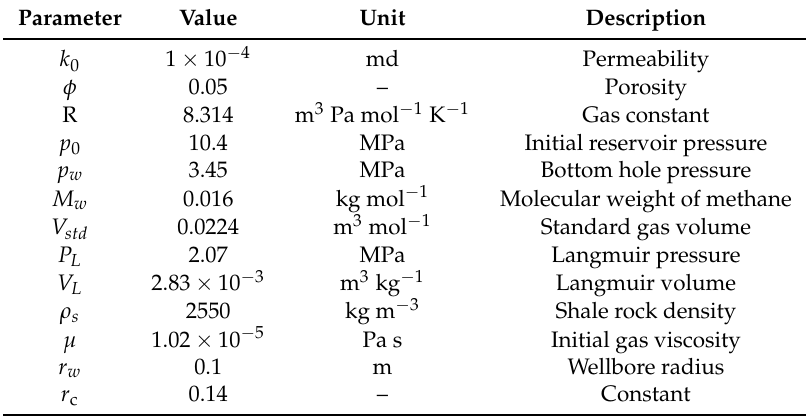
Table 1. Physical parameters of the model.